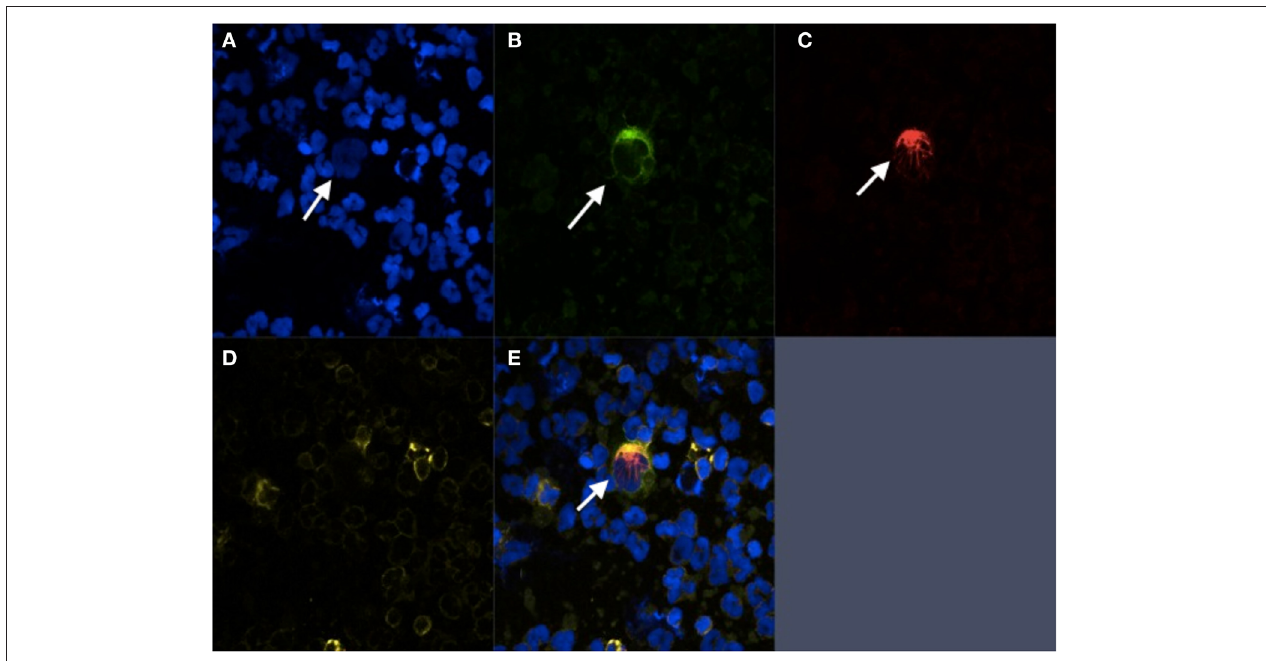
FIGURE 1 | Immunofluorescent staining of prostate cancer CTC. CTC isolated from patient with CRPC using negative selection. (A) DAPI; (B) PSMA; (C) Cytokeratin; (D) CD-45; (E) Composite